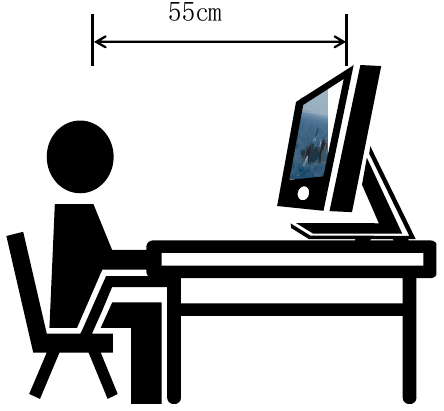
Figure A2. The experimental set-up of the visual experiment.